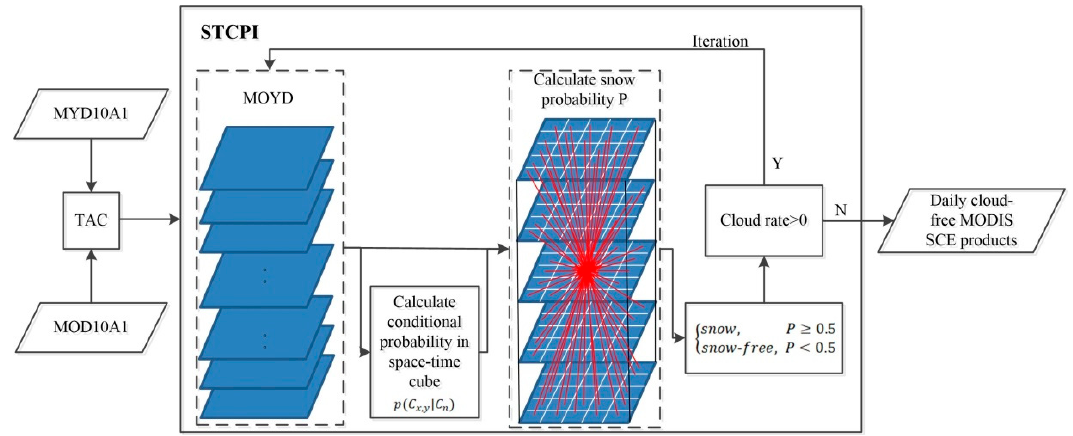
Figure 2. Flowchart for generating the daily cloud-free MODIS snow cover extent (SCE) products.